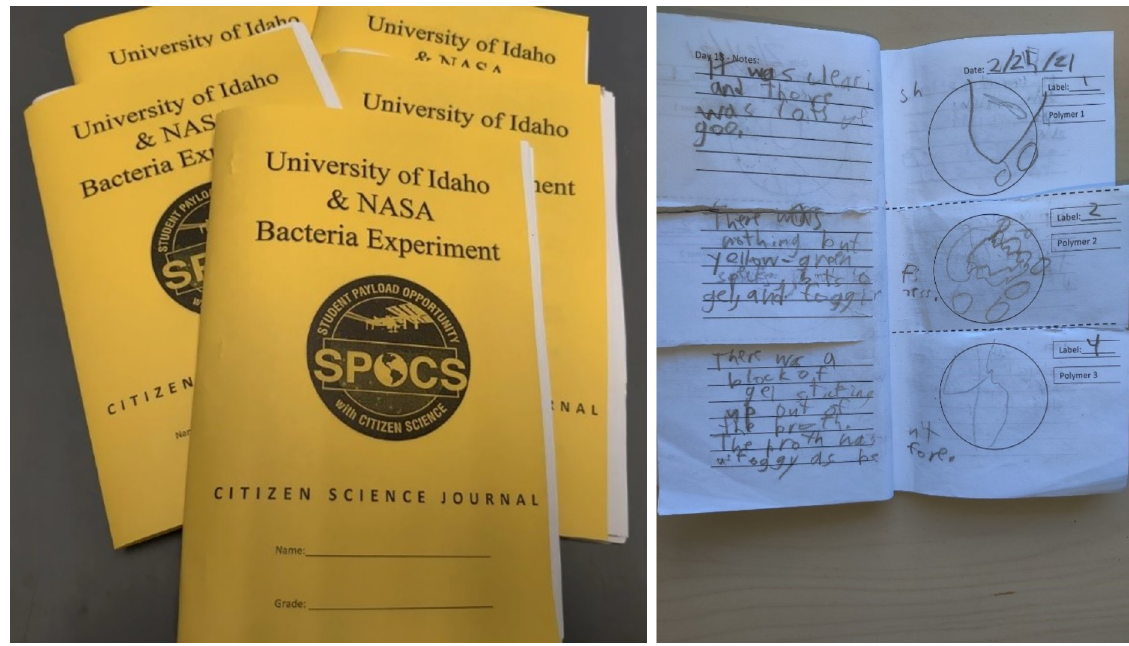
Fig 1. Citizen scientist logbooks and representative citizen scientist experimental